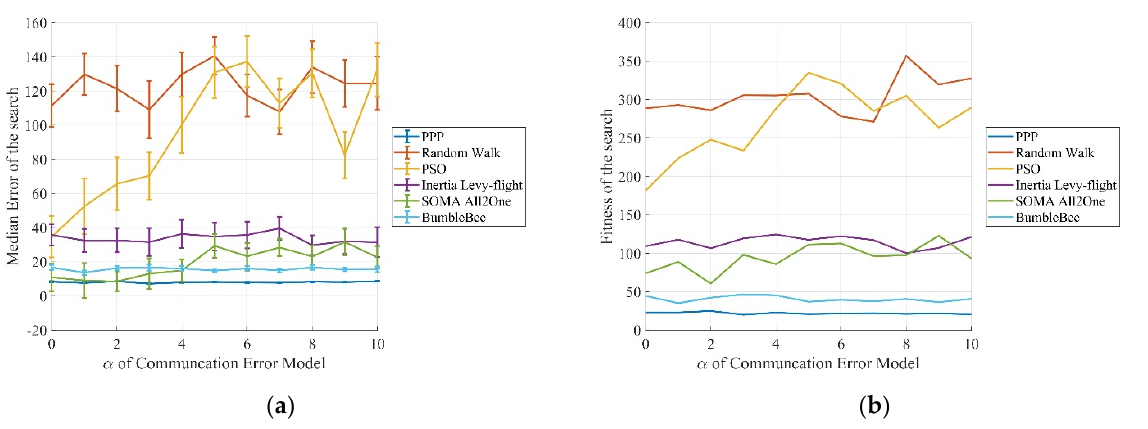
Figure 24. Median performance ( a ) and fitness ( b ) of different search strategies under the influence of increasing communication errors.